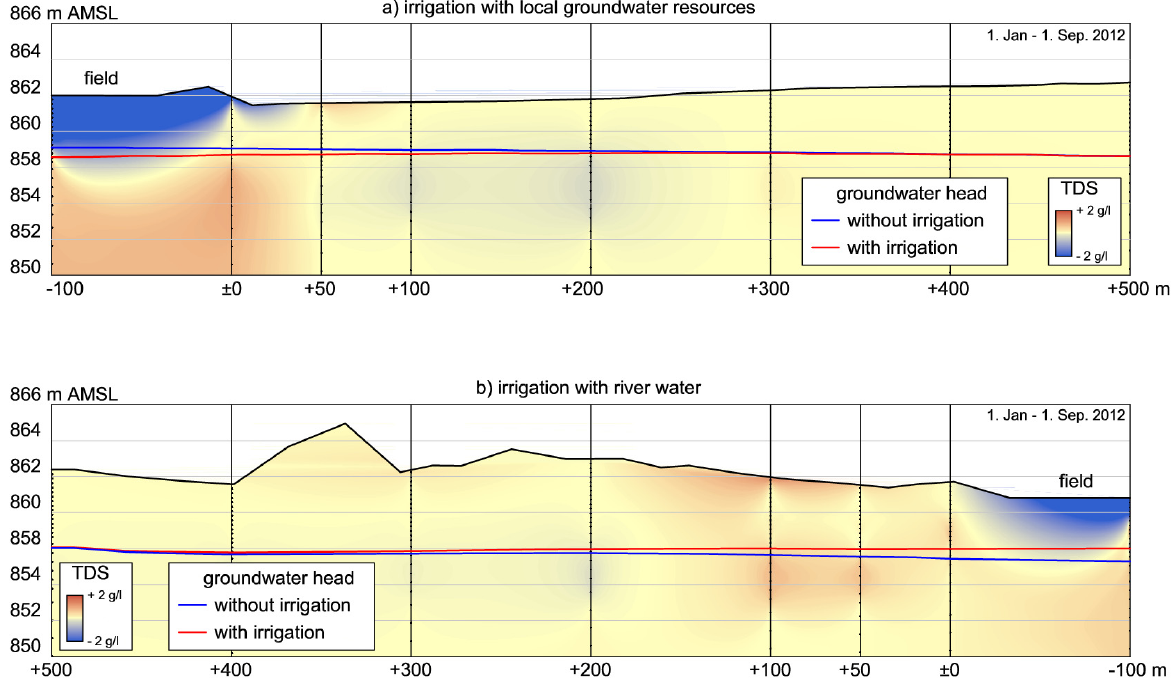
Figure 5. Changes in salt concentration and groundwater levels at transition zones when the irrigation water is used from local groundwater resources ( a ) or from the Tarim River ( b